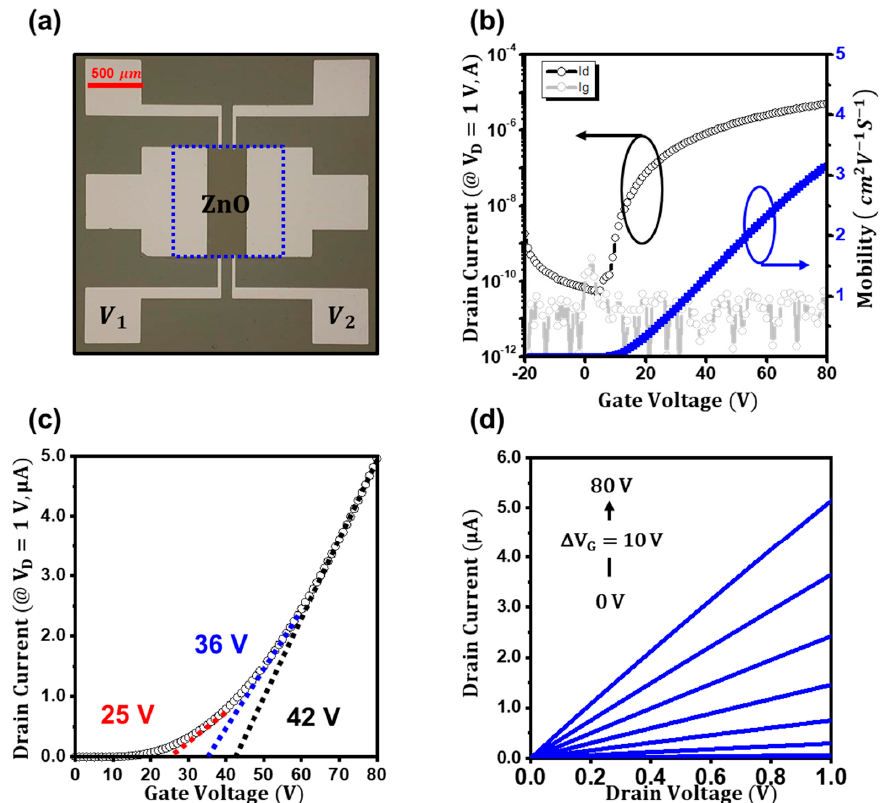
Figure 1. ( a ) Optical microscopy image of the ZnO TFTs with a four-point probe configuration. ( b ) Transfer characteristics ( I ds vs. V gs ) of the ZnO TFTs. ( c ) The threshold-voltage extraction of the ZnO TFTs with the gate bias range up to 40 (red), 60 (blue), and 80 (black) V, respectively. ( d ) Output characteristics ( I ds vs. V ds ) of the ZnO TFTs.